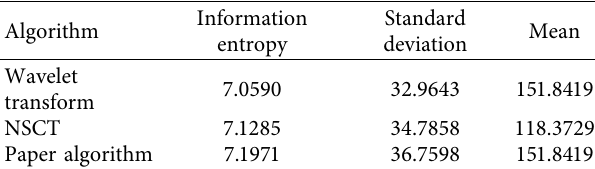
Table 6: The comparison of different fusion